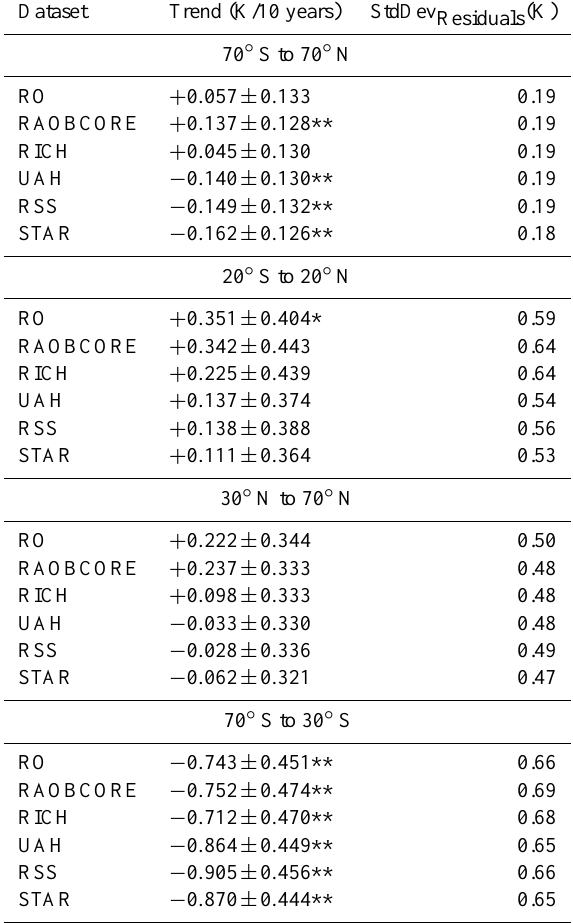
Table 1. Trends of anomalies for the period of Sep. 2001 to Dec. 2010. The ± value defines the 95 % confidence intervals for the trends. Trend values which are significantly different from 0 at the 90 % and 95 % level are marked by a single and double asterisk,